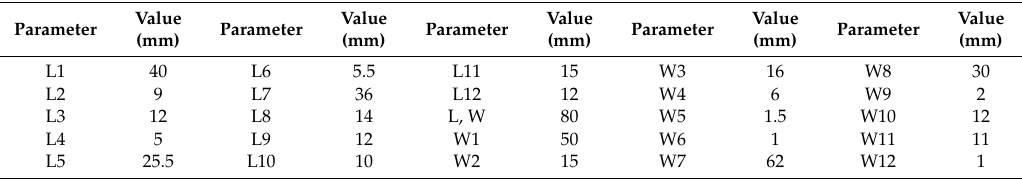
Figure 1. Schematic of the proposed antenna: ( a ) E-shaped main radiating elements; ( b ) Rectangular patch with L-shaped cuts. Table 1. Dimensions of the proposed antenna.